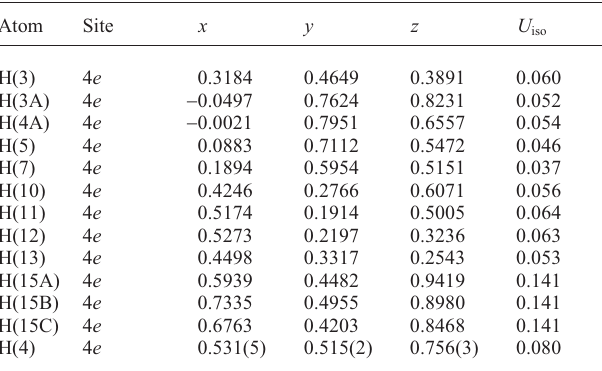
Table 2. Atomic coordinates and displacement parameters (in Å 2 )